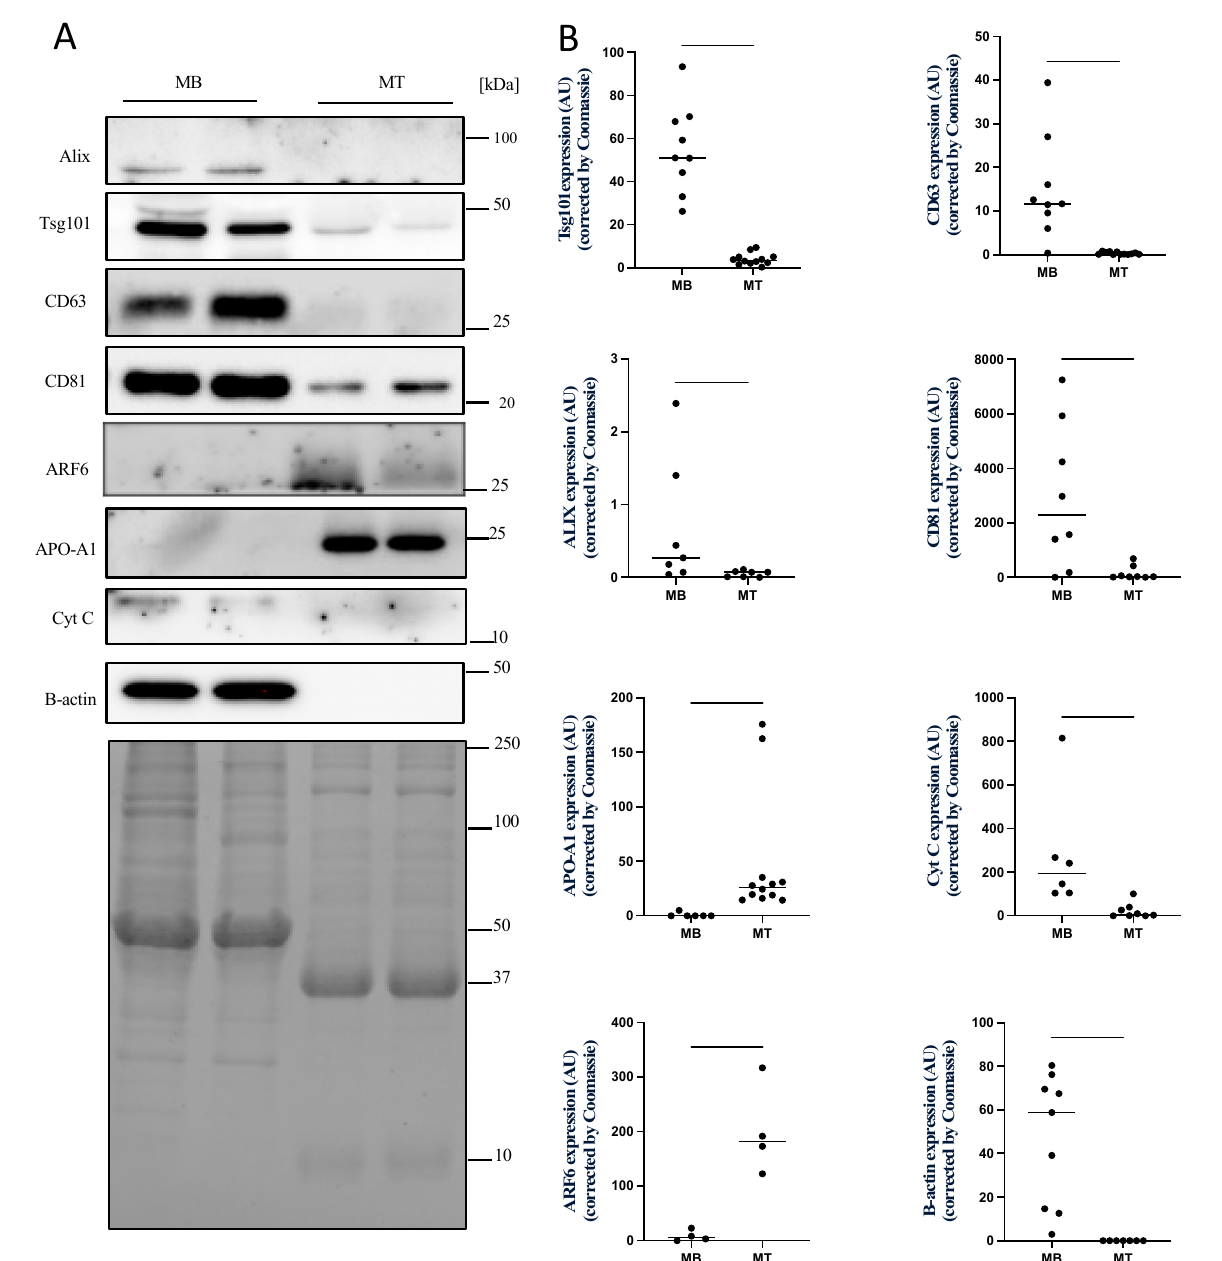
Figure 3. Effect of skeletal muscle myoblast differentiation into myotubes on the expression of proteins related to EV subtypes. ( A ) Representative immunoblots showing equal amounts (20 µg) of myoblast (MB) or myotube (MT) EP protein lysates were subjected to 12% SDS–PAGE. EPs were isolated using Total Exosome Isolation Reagent (ThermoFisher, Waltham, MA, USA). Coomassie blue gel staining was used as a loading control. ( B ) Quantification of immunoblot analysis showing the expression of different markers of small and medium/large EVs and non-EV co-isolates. Expression of small EV marker proteins TSG101, ALIX and tetraspanins CD63 and CD81 were enriched by several orders of magnitude in myoblast-EP preparations compared with myotube-EPs (* p < 0.05, ** p < 0.01, *** p < 0.001, **** p < 0.0001, n = 7–12). Conversely, levels of ARF6, a microvesicle marker, and APO-A1, a lipoprotein non-EV co-isolate, were only expressed in myotube-EPs when compared with myoblast-EPs (* p < 0.05, ** p < 0.01, n = 4–12). Cytochrome c and beta-actin were barely expressed in myotube-EPs compared to myoblast-EPs (** p < 0.01, n = 6–9). Data were analyzed using an unpaired Student’s t test and are expressed as scatter plots showing the mean.